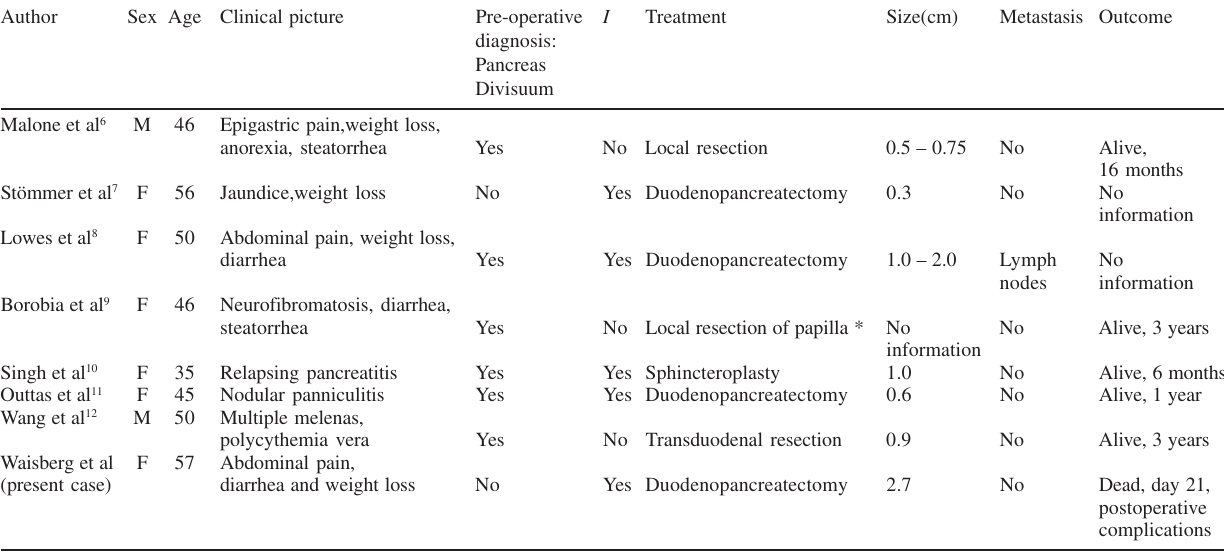
Table 1 - Main clinical aspects, morphologic features, treatment modalities, and outcome of cases of carcinoid of the minor duodenal